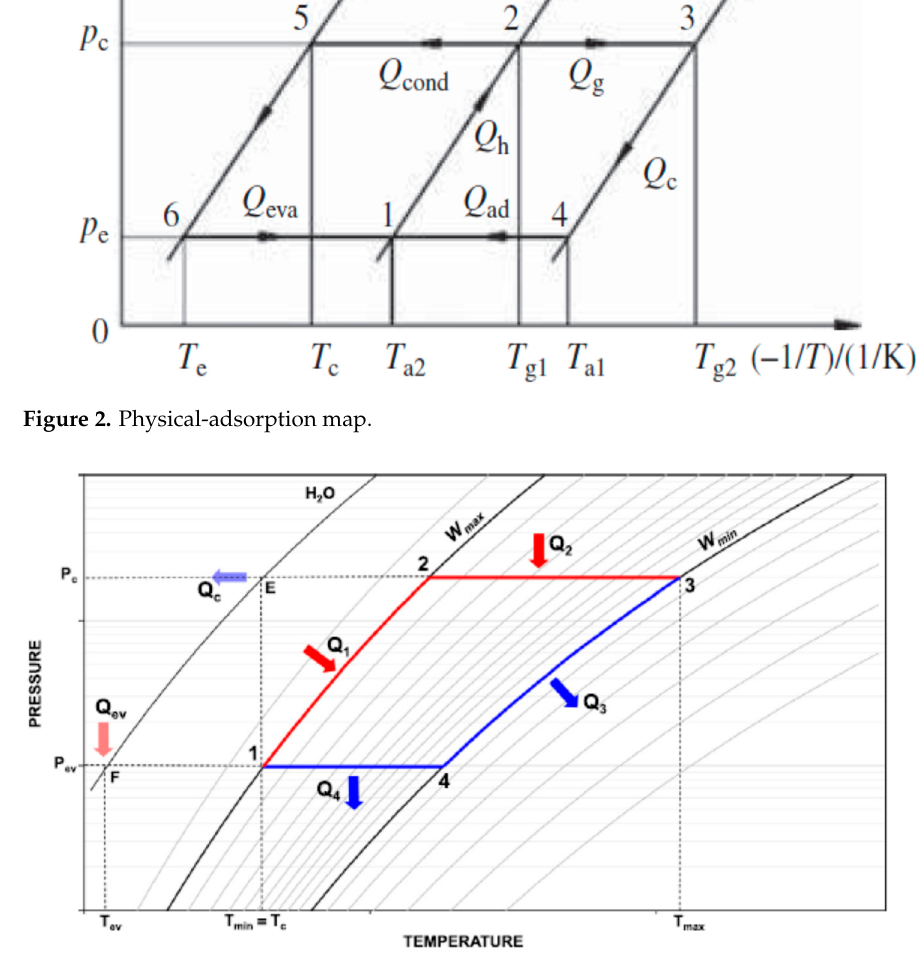
Figure 3. Pressure–temperature (P–T) diagram of physical adsorption.